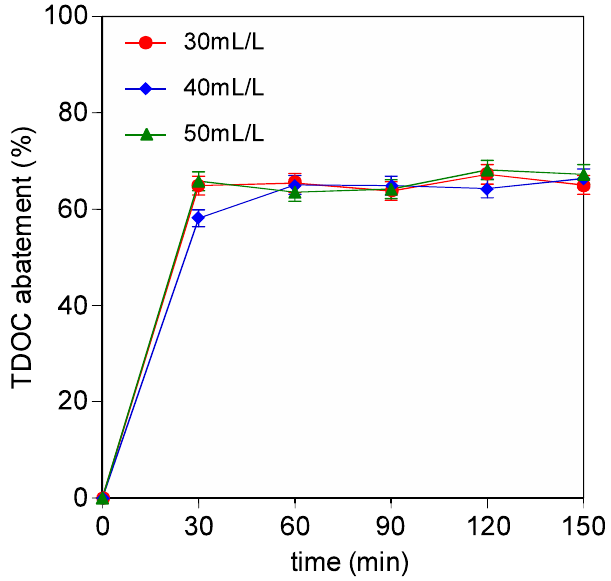
Figure 5. Dependence of process efficiency on oxidant dose (reaction condition: 70 ◦ C, pH 5, catalyst dose 200 mg/L and reaction time 150 min).